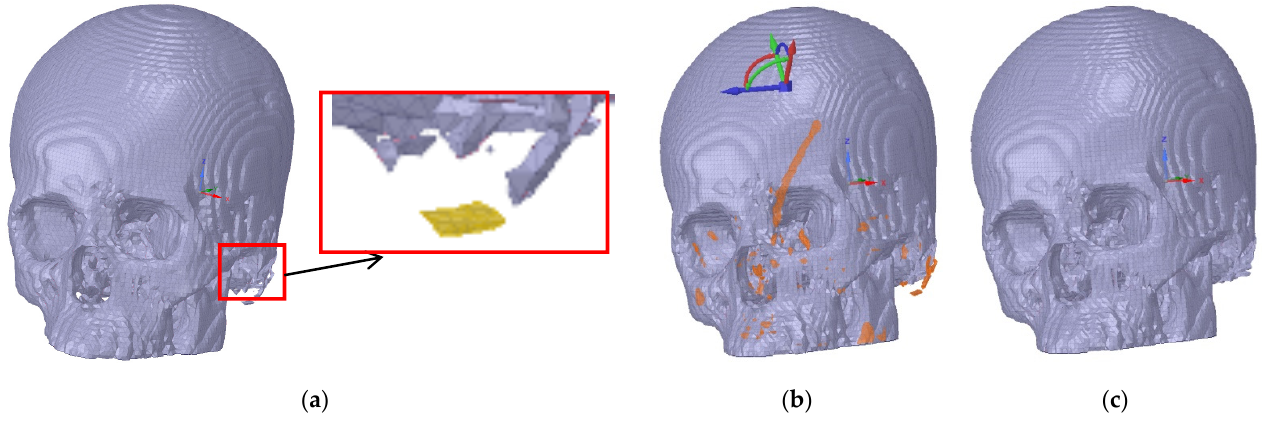
Figure 11. ( a ) Unconnected mesh body. ( b ) All unconnected mesh bodies (orange color). ( c ) Skull without unconnected mesh body.